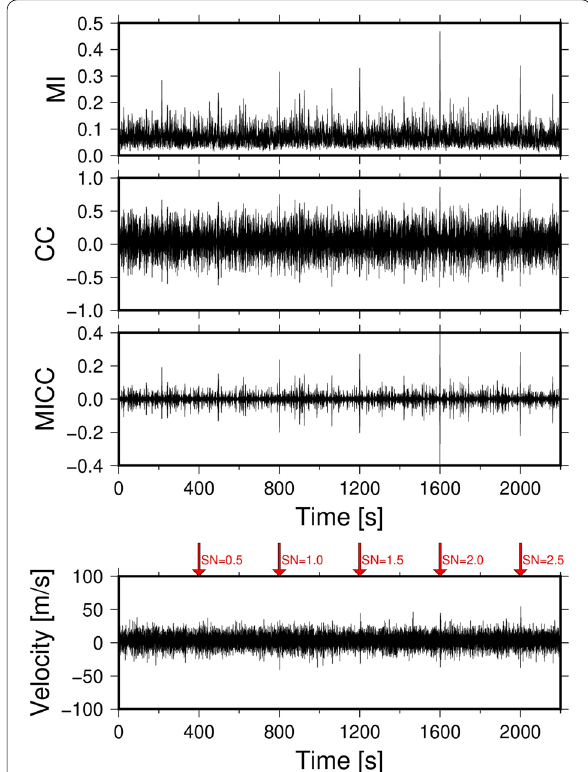
0.0 = Fig. 8 MI, CC, and MICC for the test between the template waveform and synthetic data (random noise and template waveforms). MI, CC, and MICC are calculated every 0.04 s (every sampling point). The template waveforms were added to the noise every 400 s with various SN